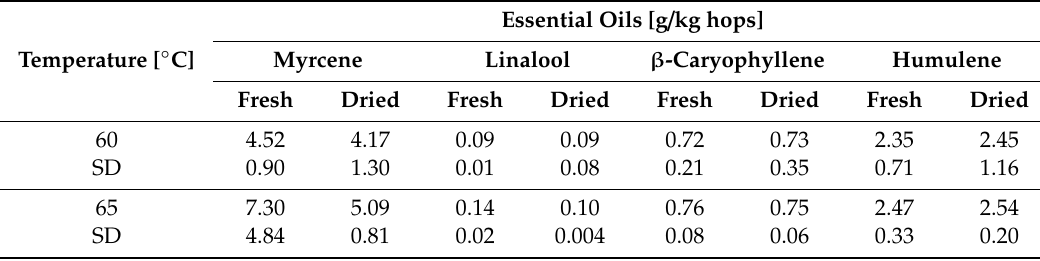
Table 5. Essential oils with standard deviation (SD) prior to and after drying process extracted using